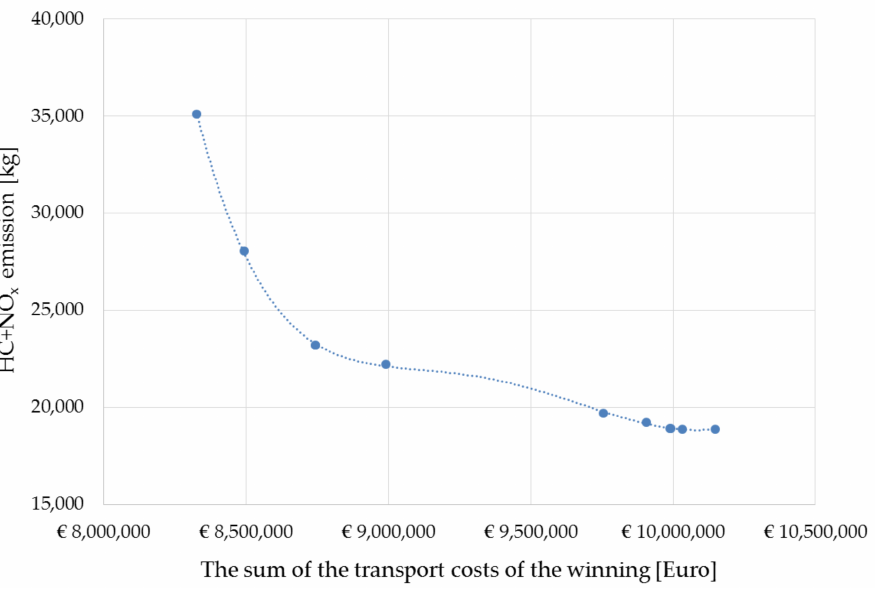
Figure 10. Dependence of the HC+NO x emission level on the transport costs of the winning, depend- ing on the adopted weights of optimization criteria as a function of the